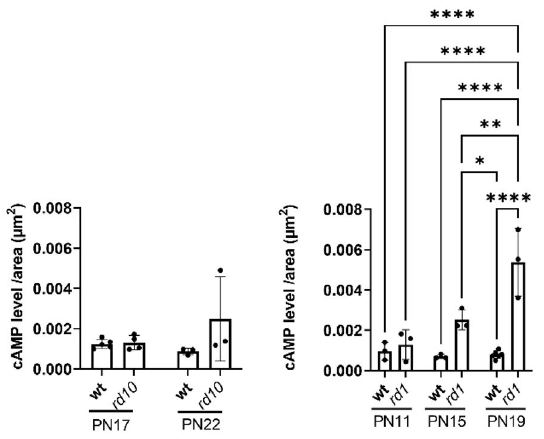
Figure 4. cAMP level increases within the ONL in degenerating rd1 retinas. The cAMP level was quantified from immunofluorescence stainings from the two rd models and given as level/area ( µ m 2 ): rd10 (left) and rd1 (right), as well as their respective wt counterparts at different ages. cAMP levels increased with time in rd1 but were not altered significantly in rd10 or wt. Graphs represent three to six biological replicates, and bars represent mean ± SD; levels of significance are: * p < 0.05, ** p < 0.01, **** p <